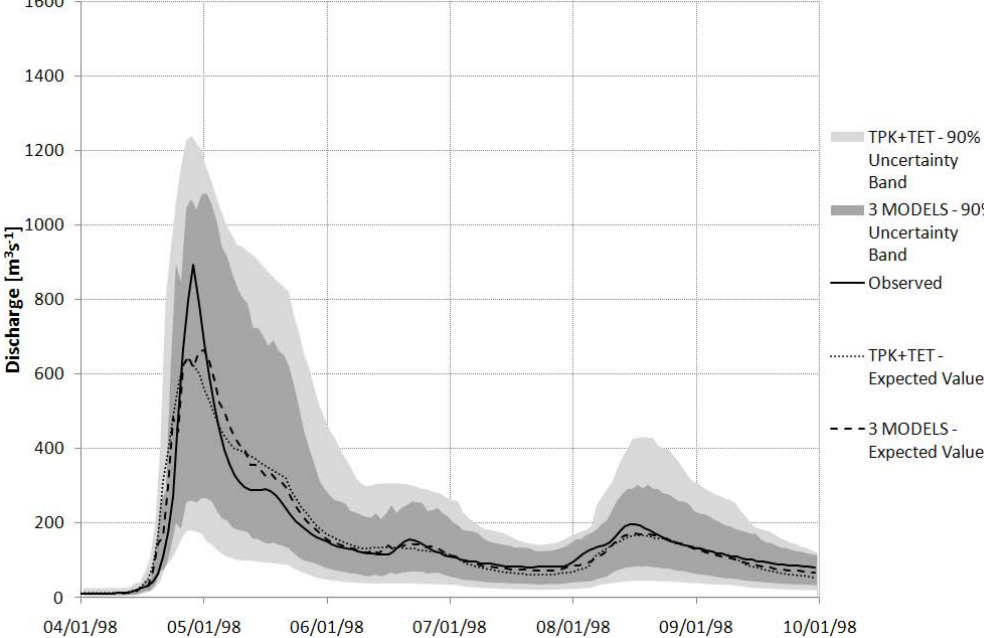
Fig. 16. Comparison between the PU computed combining, two or three models on a flood event for the validation period. Observed discharges (black line); expected value conditioned only to the TOPKAPI and TETIS forecasts (dotted line); expected value conditioned to the TOPKAPI, TETIS and ANN forecasts (dashed line); 90% uncertainty band conditioned to the TOPKAPI and TETIS forecasts (light grey band); 90% uncertainty band conditioned to the TOPKAPI, TETIS and ANN forecasts (grey band).